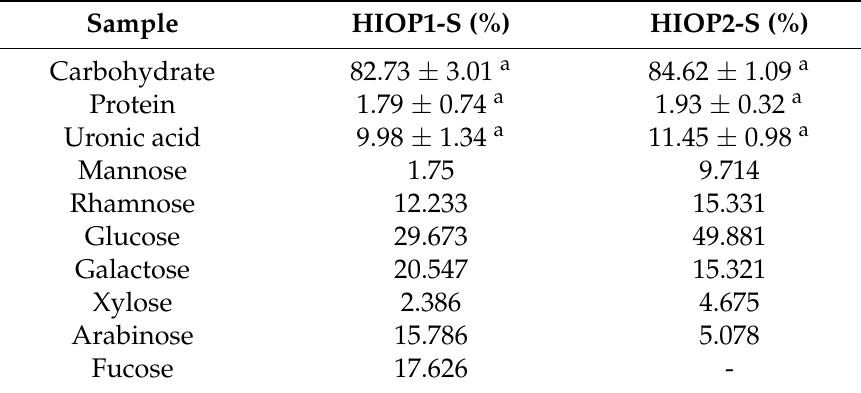
Table 1. Monosaccharide composition and